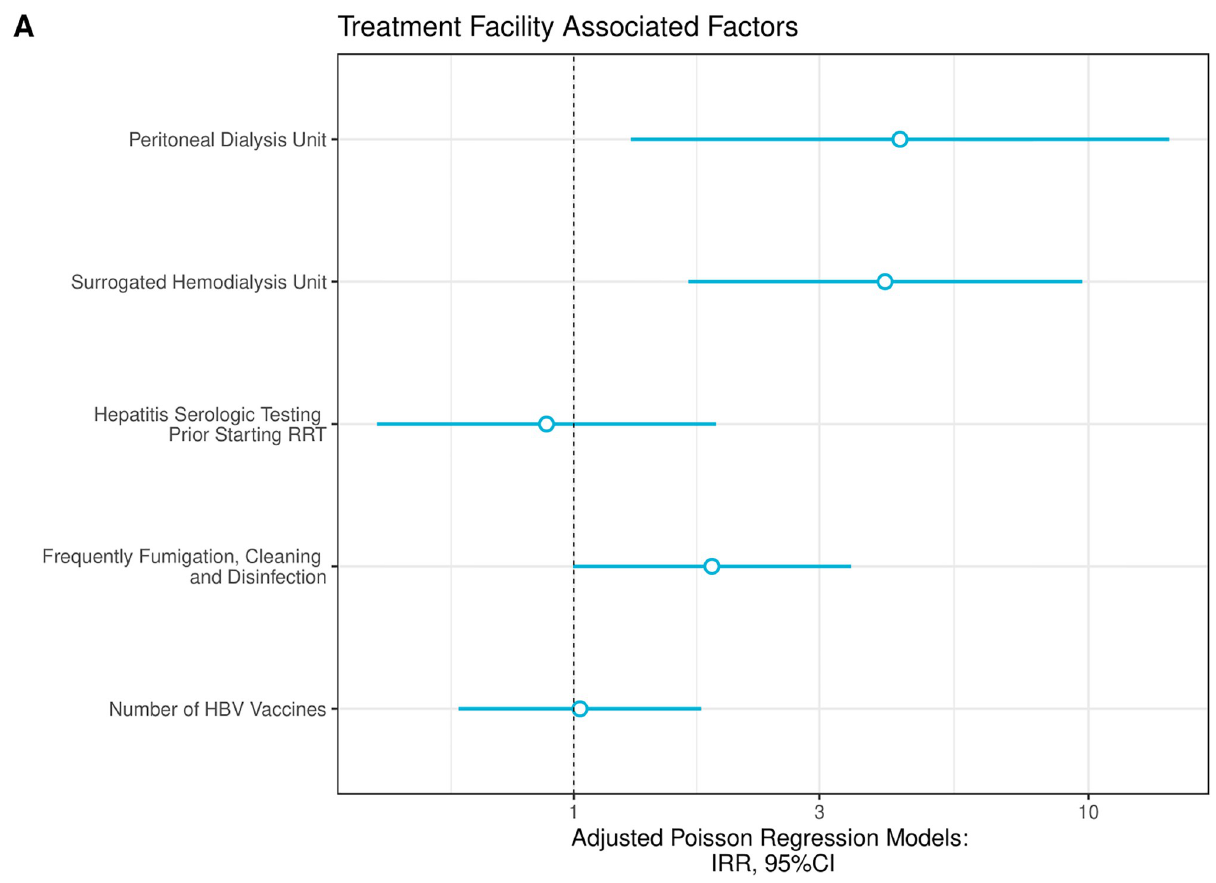
Fig 3. Poisson regression models to assess treatment facility factors related to any viral coinfection